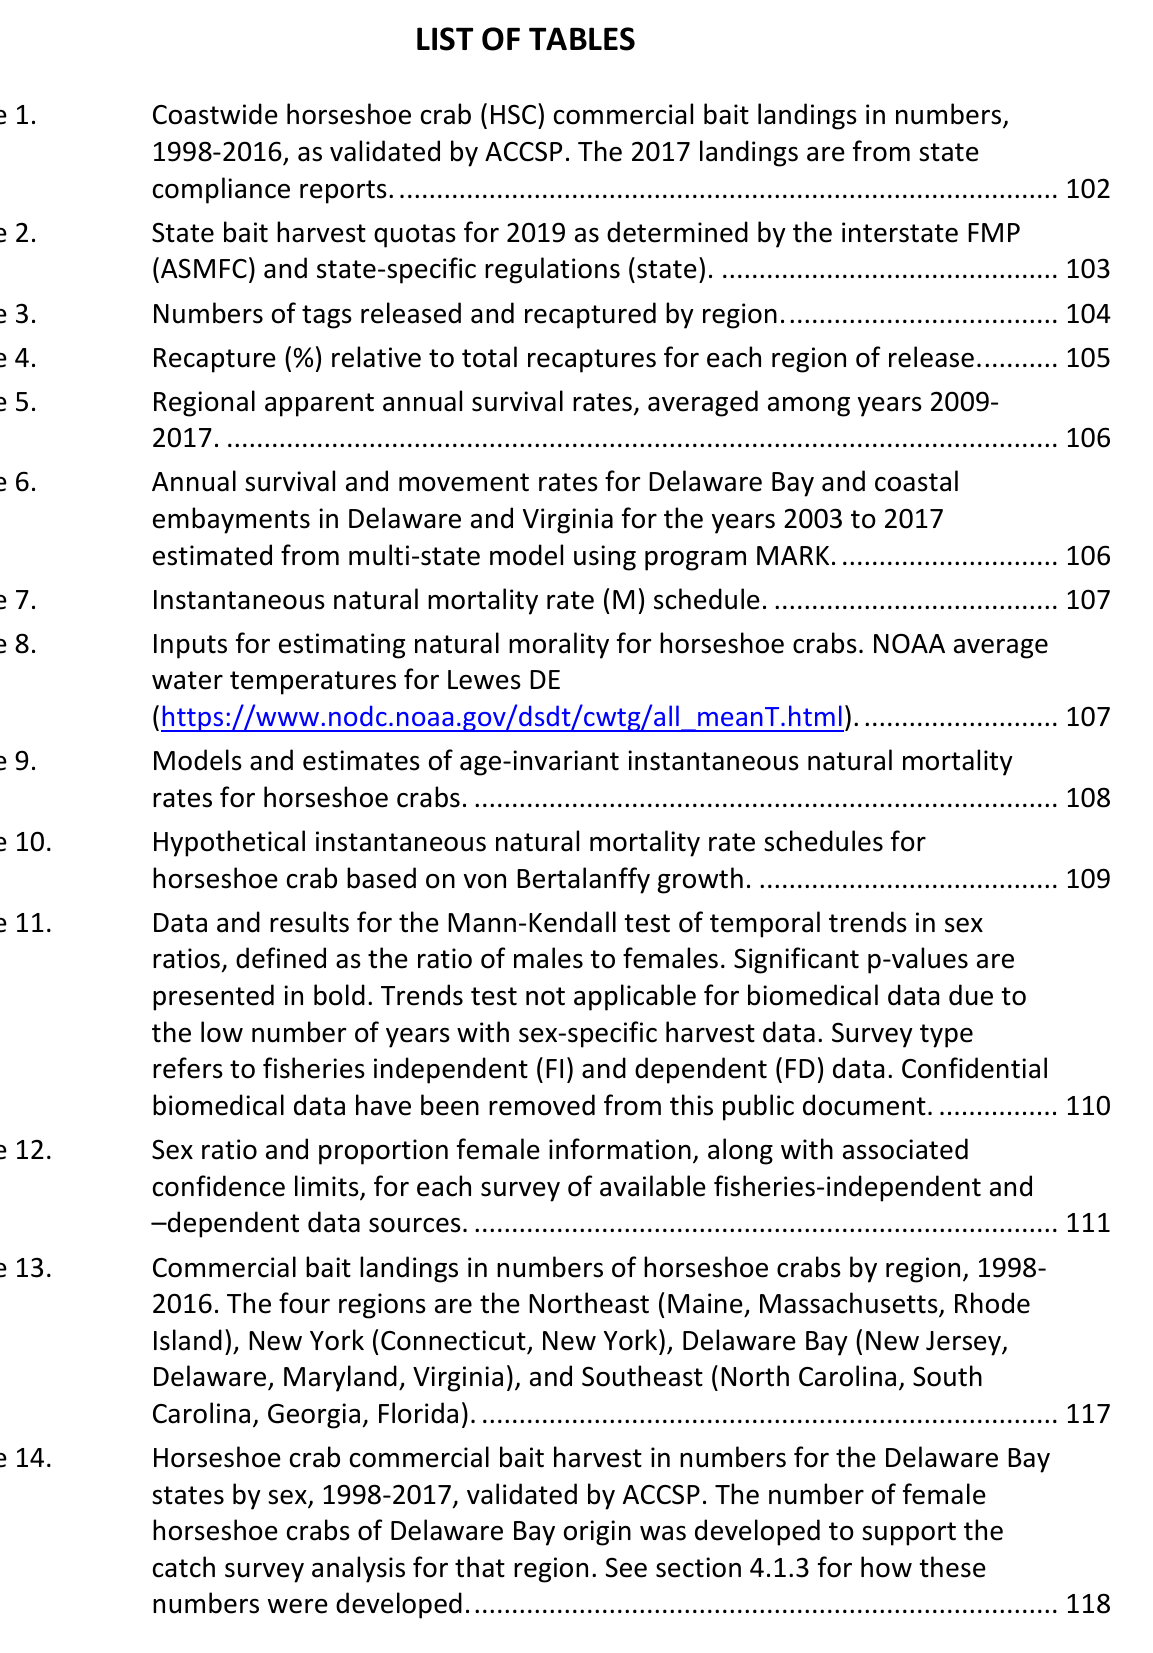
Coastwide horseshoe crab (HSC) commercial bait landings in numbers, 1998-2016, as validated by ACCSP. The 2017 landings are from state compliance reports. ........................................................................................ 102 State bait harvest quotas for 2019 as determined by the interstate FMP (ASMFC) and state-specific regulations (state). ............................................. 103